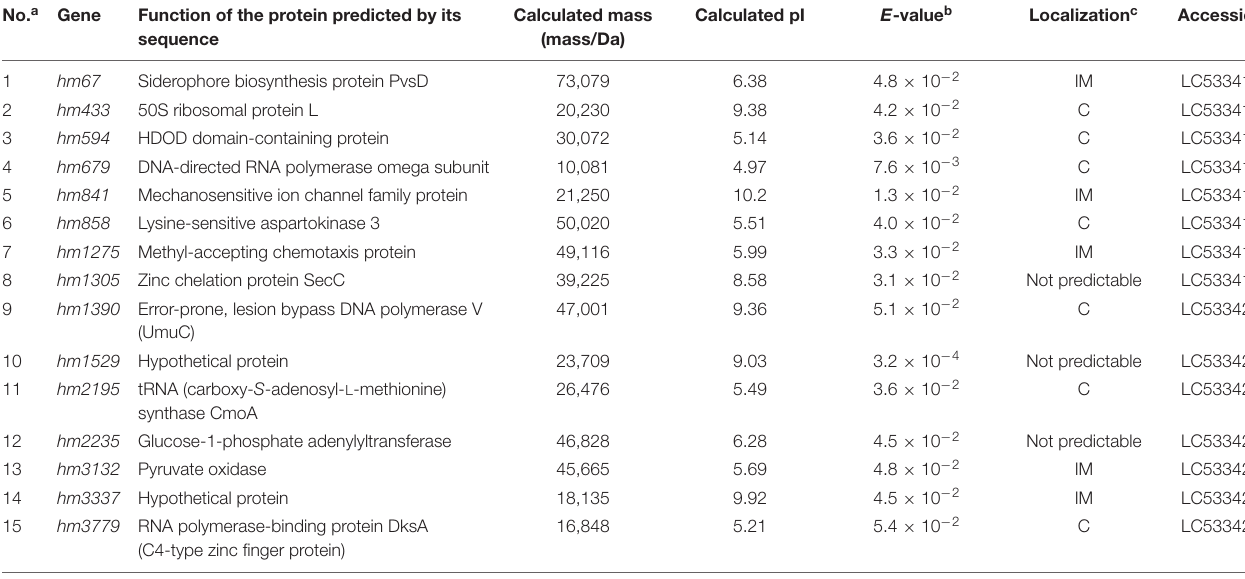
TABLE 3 | The identified proteins in EMVs from (cid:49)